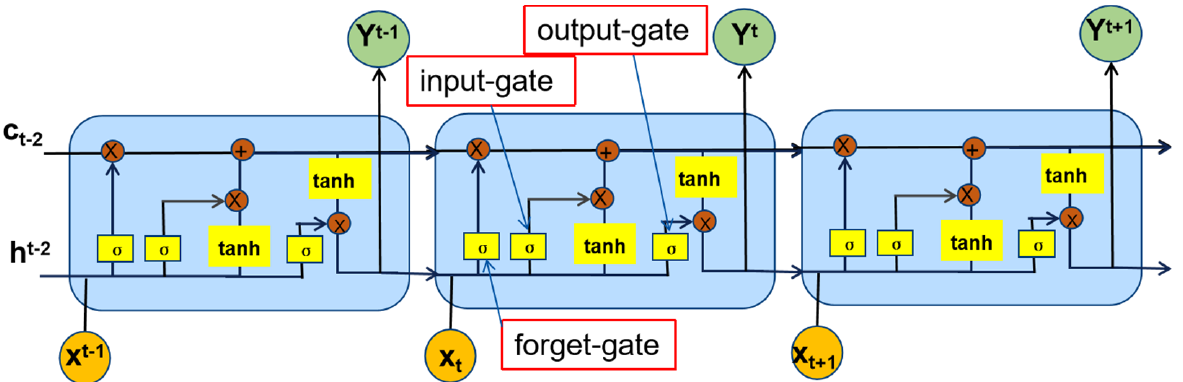
Figure 6. Node structure of the